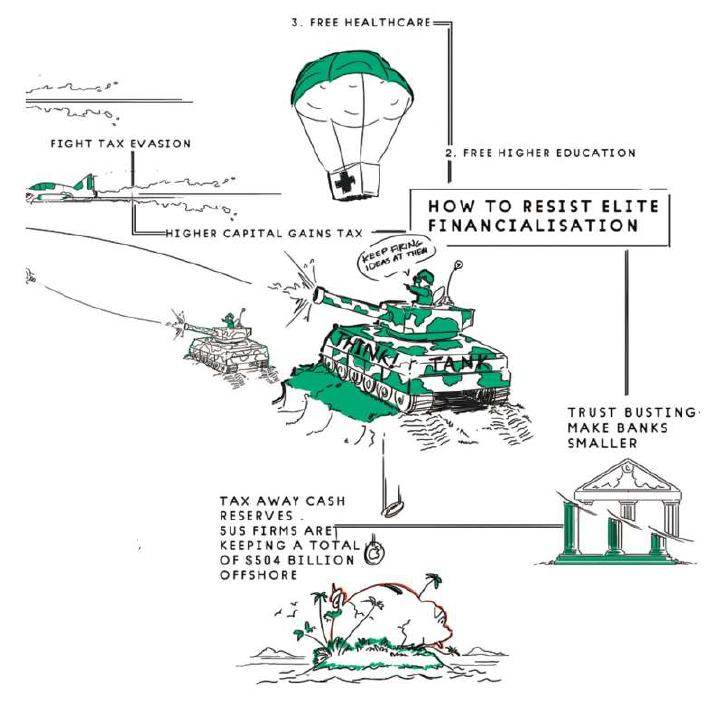
Figure 5. Resistance to Elite Financialisation